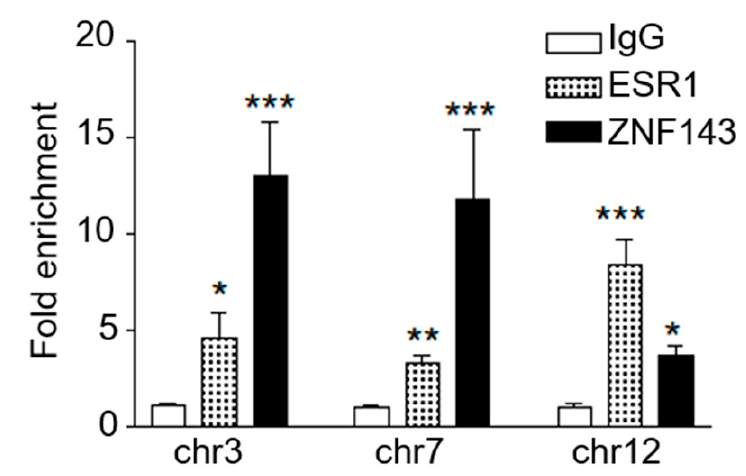
Figure 4. ChIP-qPCR confirmed enrichment of ESR1 and ZNF143 at three genomic sites identified in the E2-Independent sample. Data is shown as fold enrichment over the IgG control. Asterisks indicate statistically significant difference between ESR1/ZNF143 and the IgG control (ANOVA with Bonferroni post-test, * p < 0.05; ** p < 0.01; *** p < 0.001). See Supplemental Table S5 for information about the three chromatin